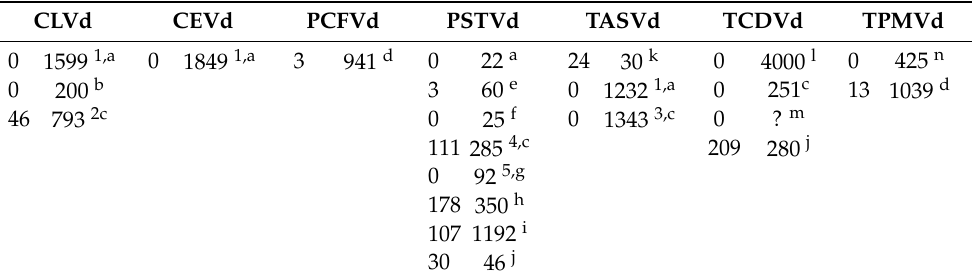
Table 5. The number of infected/raised tomato seedlings in 22 separate grow-out trials of experimen- tally produced seeds reported in the literature. CLVd CEVd PCFVd